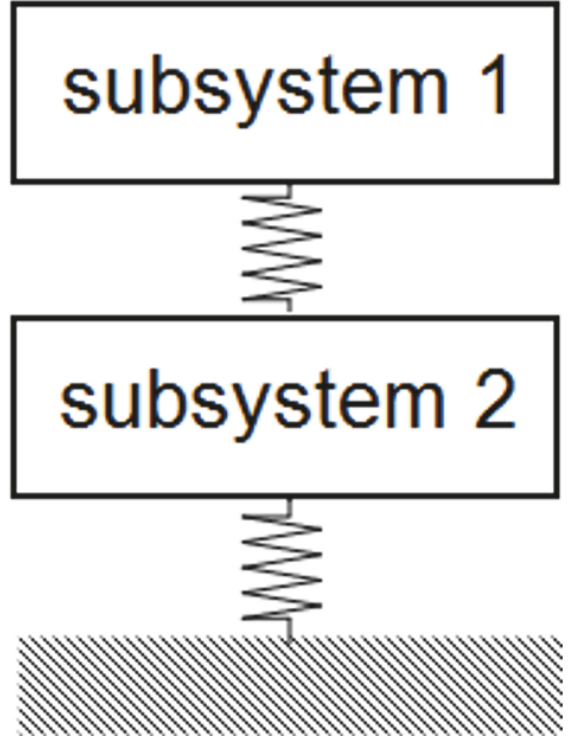
Figure 1: Simple two-DOF